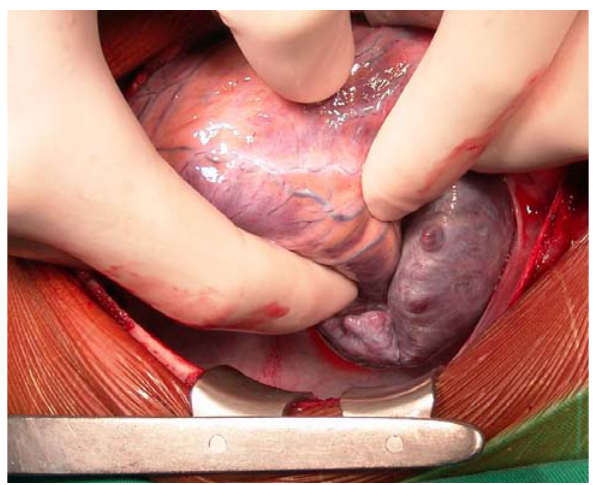
Fig. 3 – Justaposição de apêndices atriais à esquerda